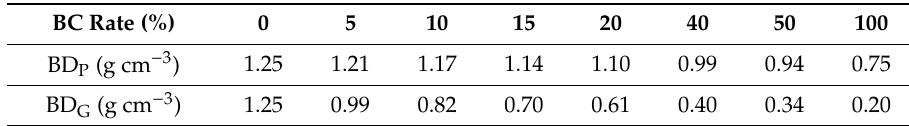
Table 2. Bulk densities (BDs) for each biochar (BC):soil mixture of both powdered (BC P ) and granular (BC G )